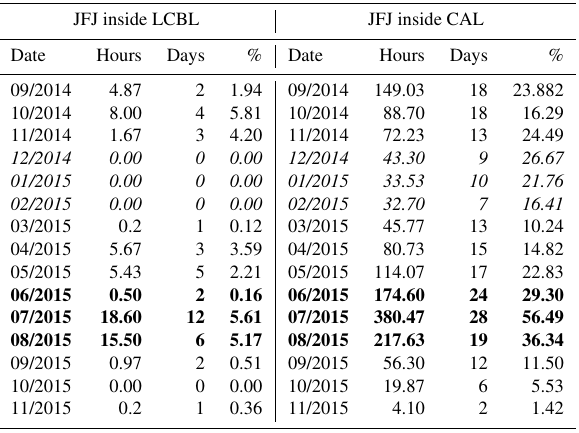
Table 1. Statistics of frequency of LCBL and CAL reaching or em- bedding the JFJ.